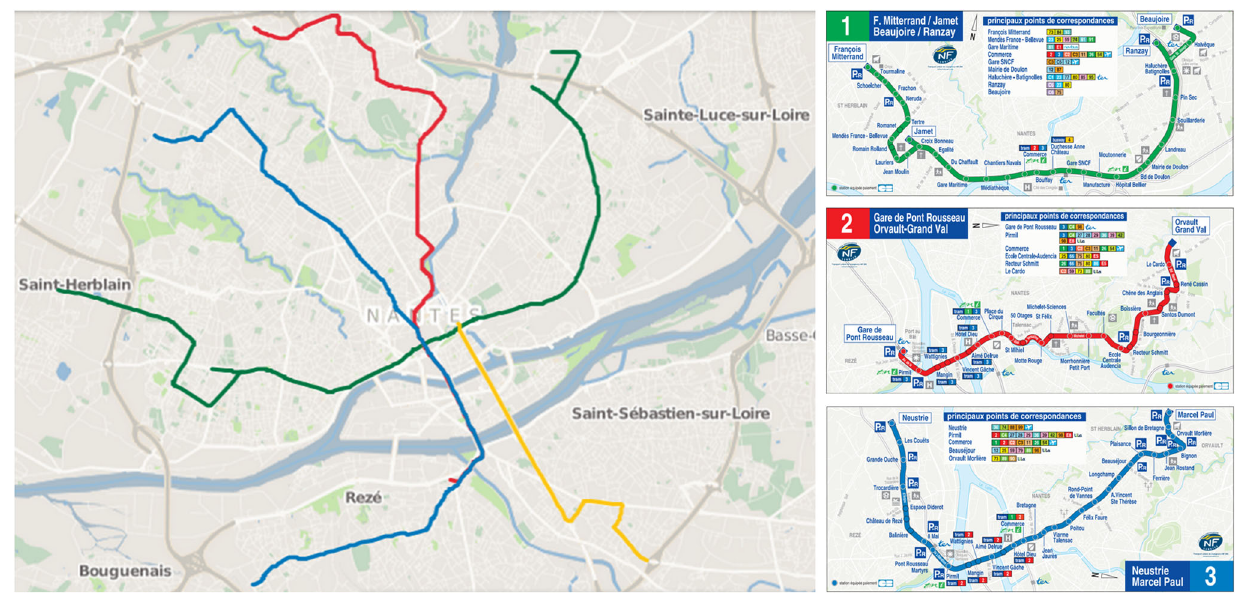
Fig. 1 The Nantes light rail network. ( Source :